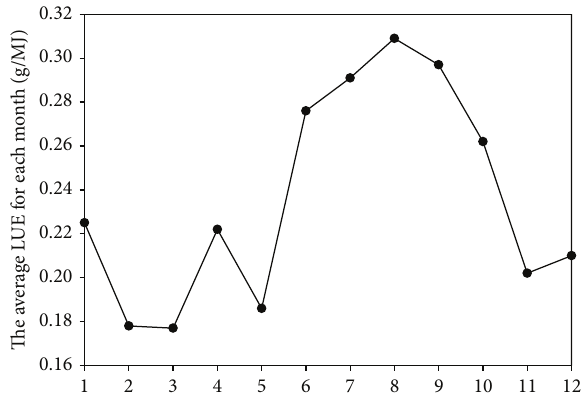
Figure 6: Monthly variation of LUE in 2011.